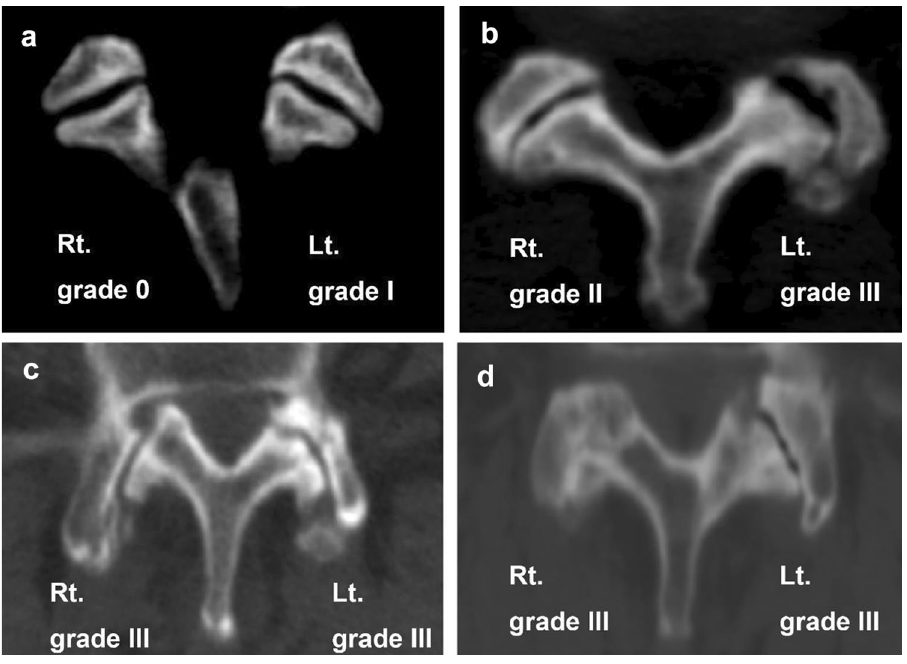
Figure 1. Representative CT images for 4 grades of facet joint